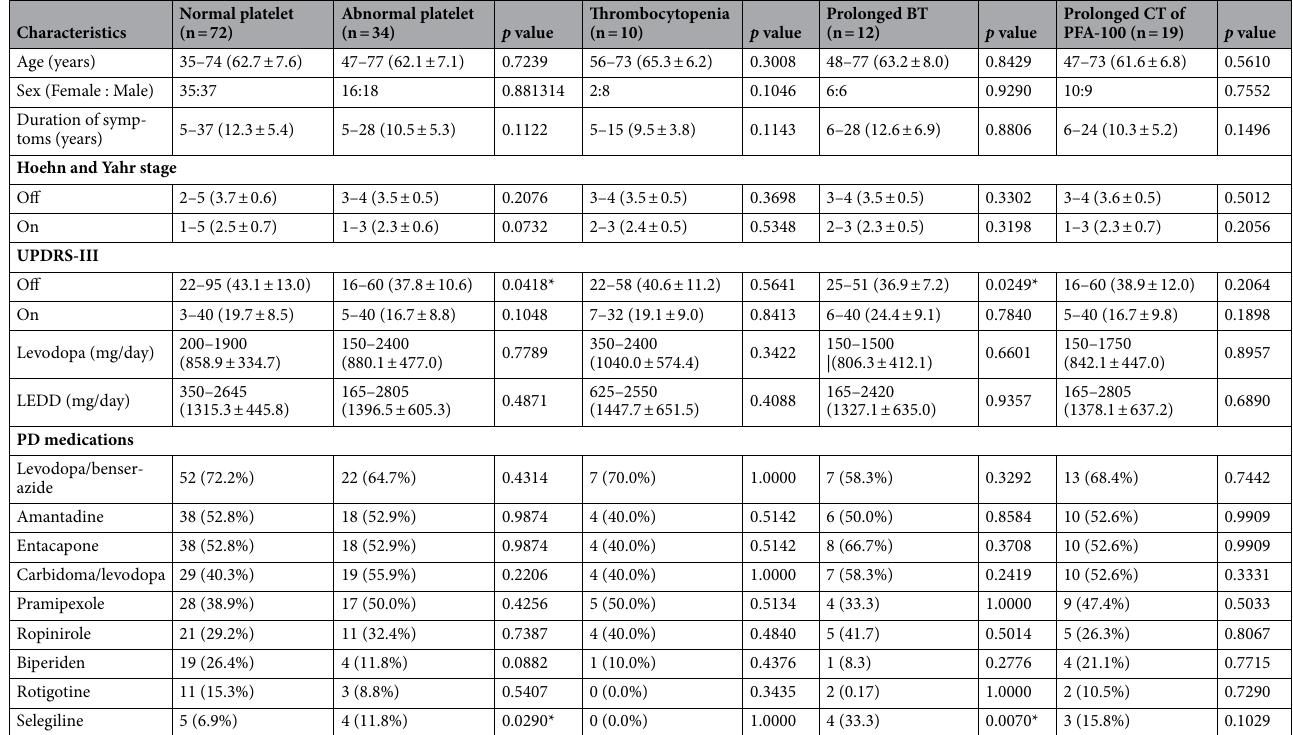
Table 2. Comparison of various factors in PD patients between normal platelet and abnormal platelet group or each test. PD, Parkinson’s disease; BT, bleeding time; CT, closure time; PFA-100, Platelet Function Analyzer-100; UPDRS, Unified Parkinson’s Disease Rating Scale; LEDD, levodopa equivalent daily dose. *Statistically